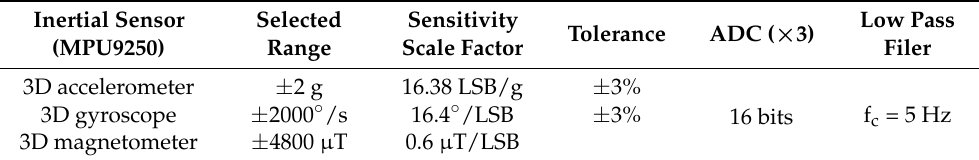
Table 1. Technical parameters of the MPU9250 inertial sensors.